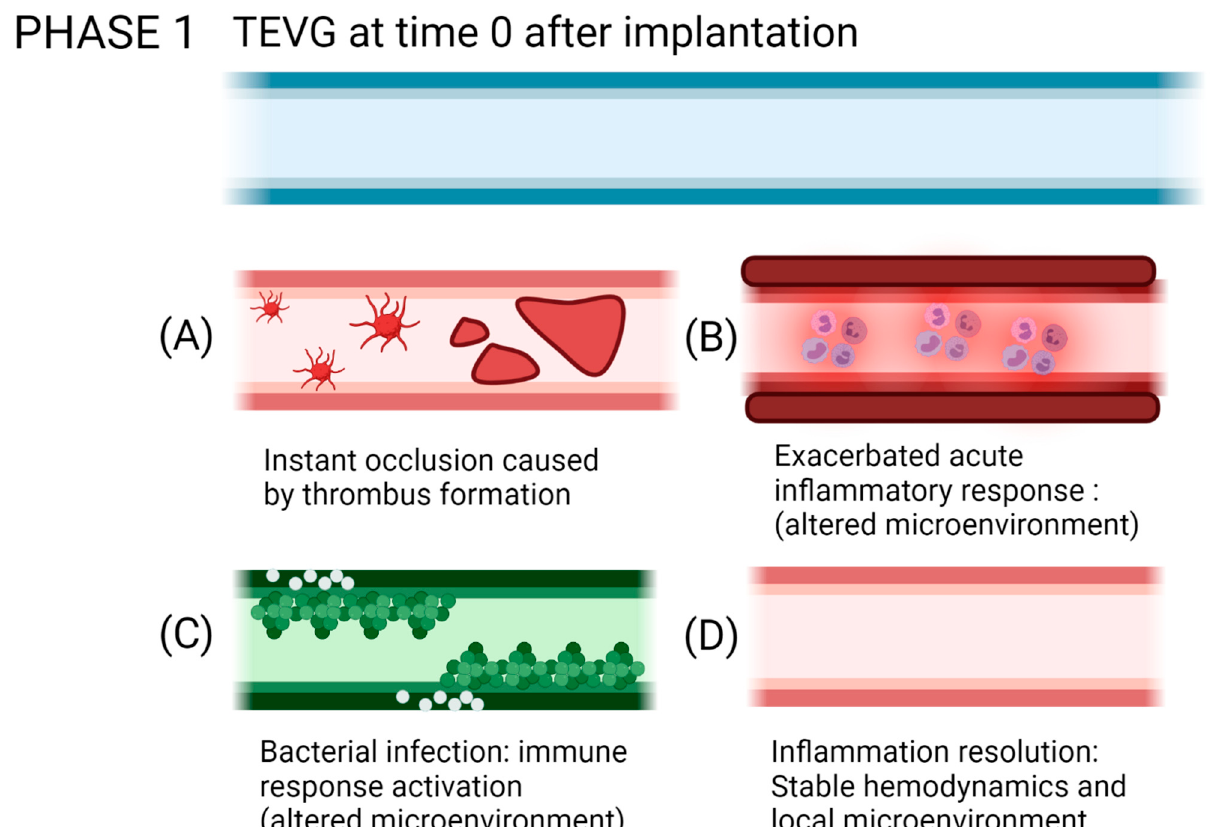
Figure 10. Possible outcomes of the interaction of TEVGs with the native microenvironment if the failure mechanisms are activated within the early stages of integration. ( A ) Instant thrombus formation causes a significant reduction of the lumen of the graft, ( B ) while an exacerbated inflammatory state reduces the possibilities to initiate a regenerative pathway. ( C ) If infection occurs, the pathogens will repopulate the graft instead of the native cells. ( D ) If after acute inflammation, the microenvironment stabilizes; the graft becomes a suitable substrate for tissue remodeling (created with BioRender.com, accessed on 7 November 2021).